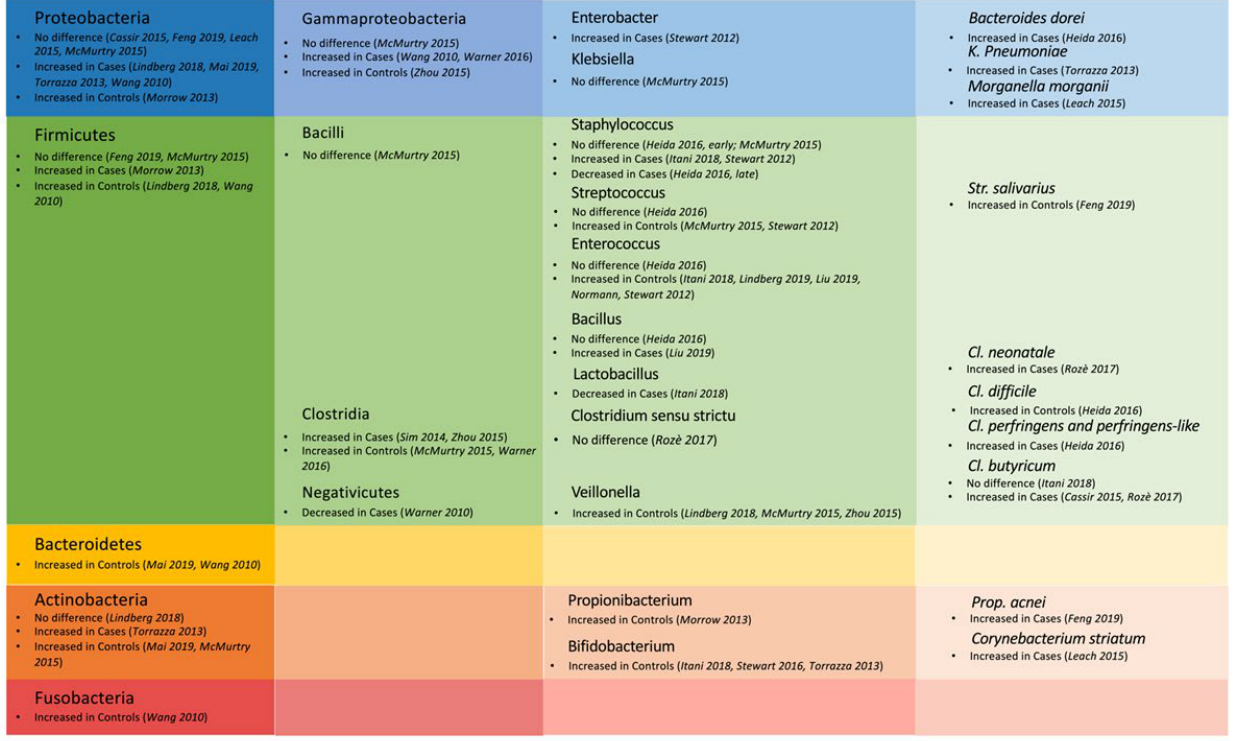
Figure 2. Main findings from the studies applying gut microbiota analysis at the phyla, classes, genera, and species level, who are predominant in cases and controls. References [26,29,35,39–47,49–51,53,54,56,57].